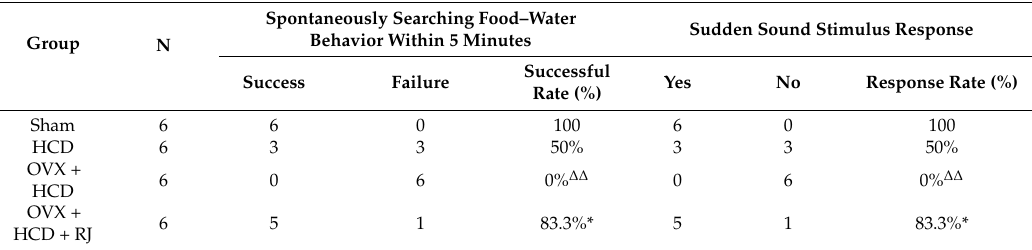
Table 2. Changes in searching food–water and sound stimulus responses in each group.